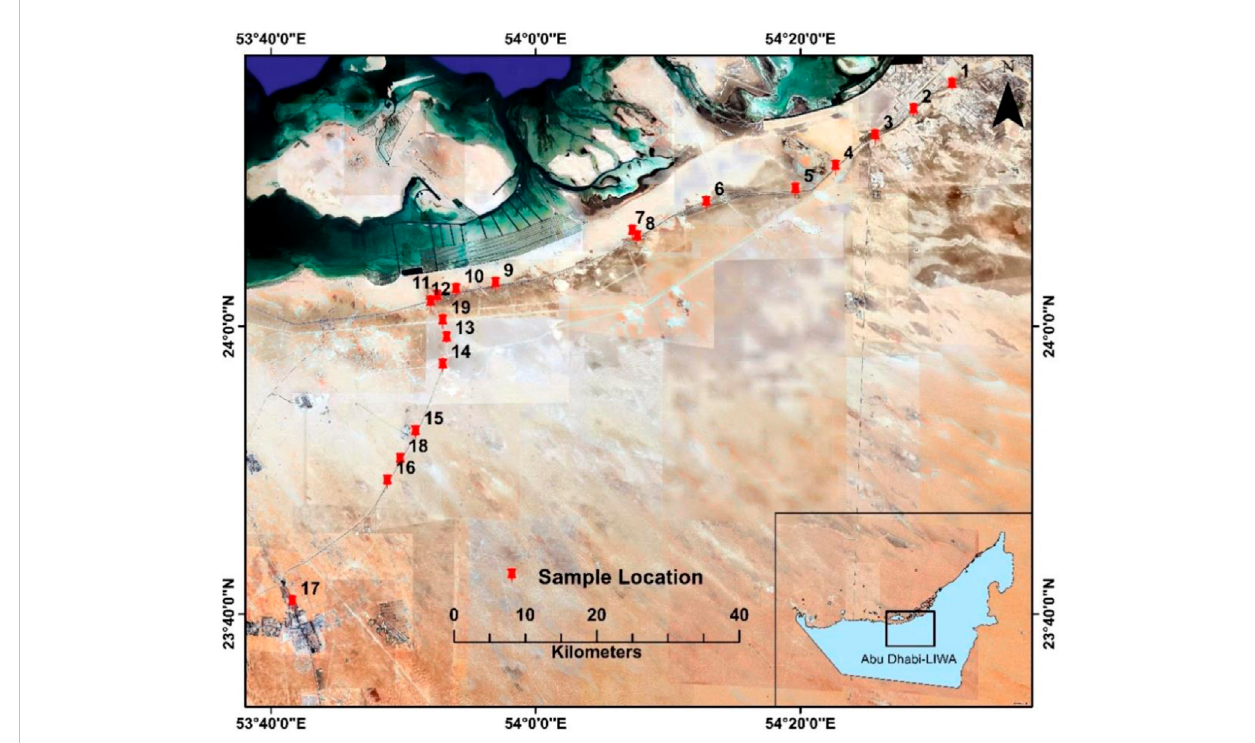
FIGURE 1 Location map of the roadside dust sampling sites obtained along the Abu Dhabi-Liwa Highway.